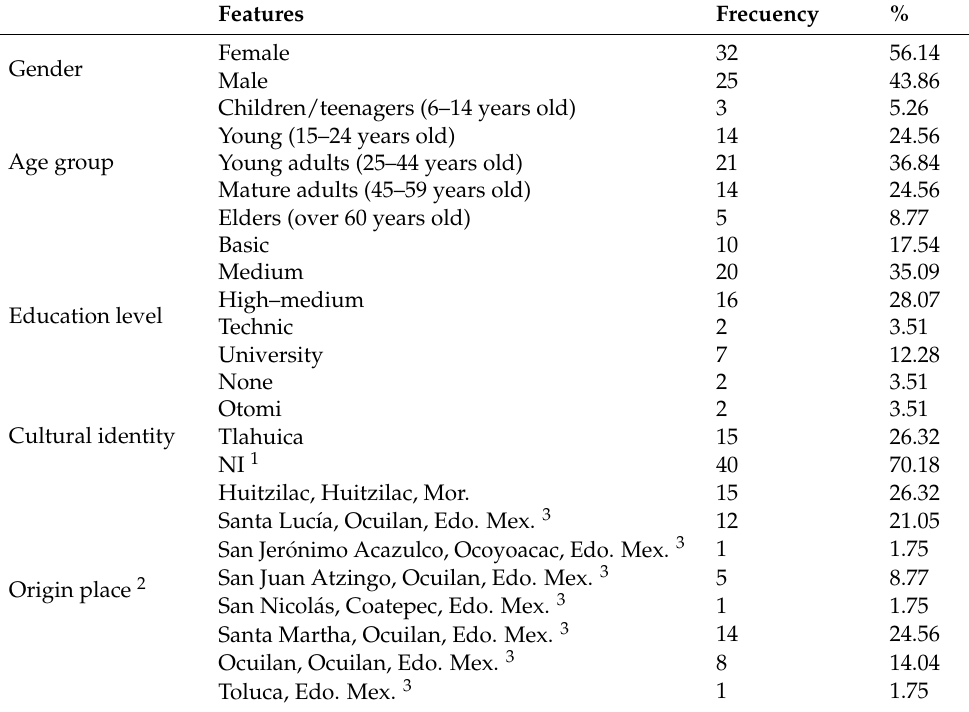
Table 2. Demographic, social, and cultural features of the people